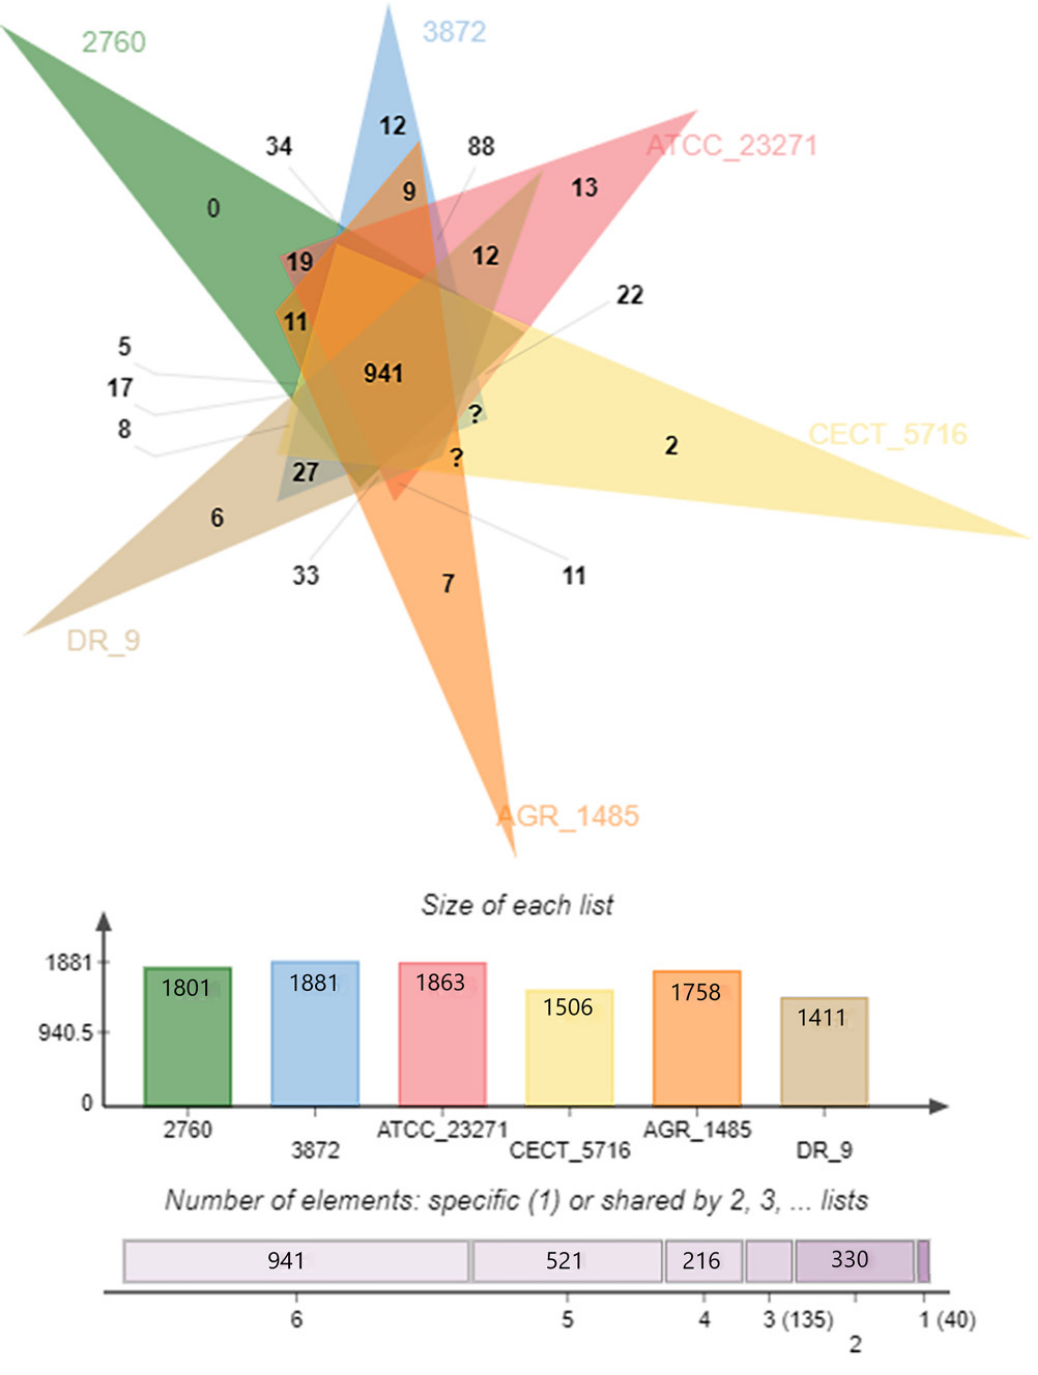
Figure 2. Venn diagram representing the groupings of orthologous genes shared between the following lineages of L. fermentum : ATCC 23271, 2760, 3872, CECT 5716, AGR 1485, and DR 9.